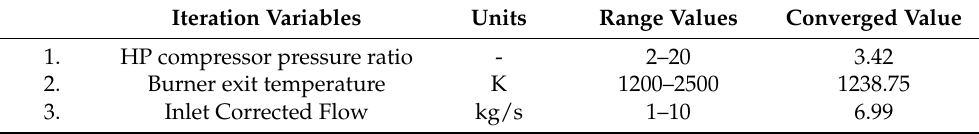
Table 3. Saturn 20 Design Point Iteration Variables and Corresponding Converged Values.